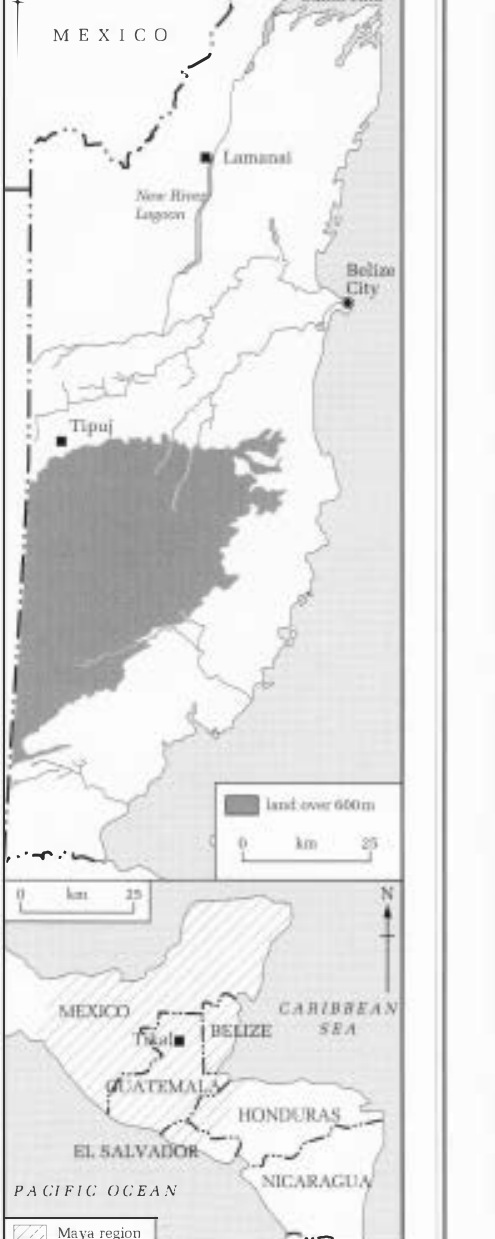
Figure 1 Belize and the Maya region, showing the location of the archaeological sites mentioned in the